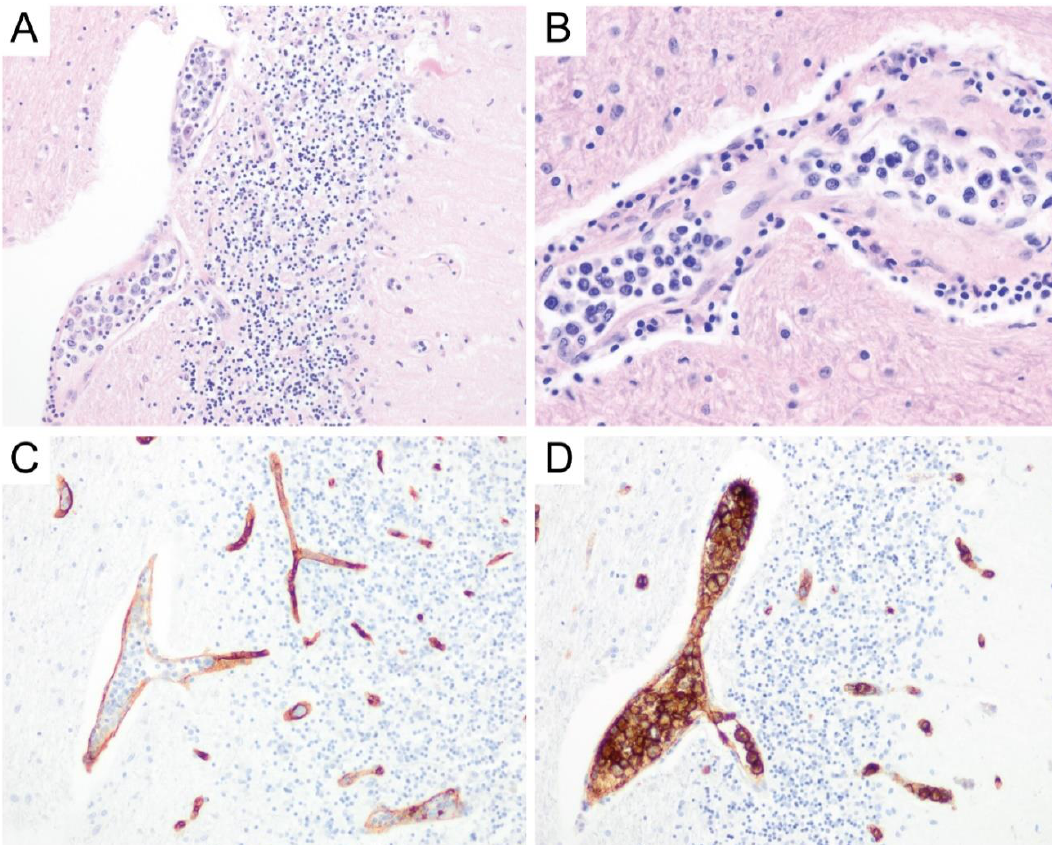
Figure 6. Intravascular large B-cell lymphoma. Intravascular large B-cell lymphoma demonstrates a proliferation of tumor cells confined to the lumina of blood vessels ( A , original magnification × 200). Tumor cells have large round nuclei with prominent nucleoli and scant cytoplasm ( B , original magnification × 400). Immunohistochemically, the endothelial cells of blood vessels can be highlighted using antibodies against CD34 ( C , original magnification × 200). The neoplastic lymphocytes within vessels express CD20, confirming B-cell lineage ( D , original magnification ×